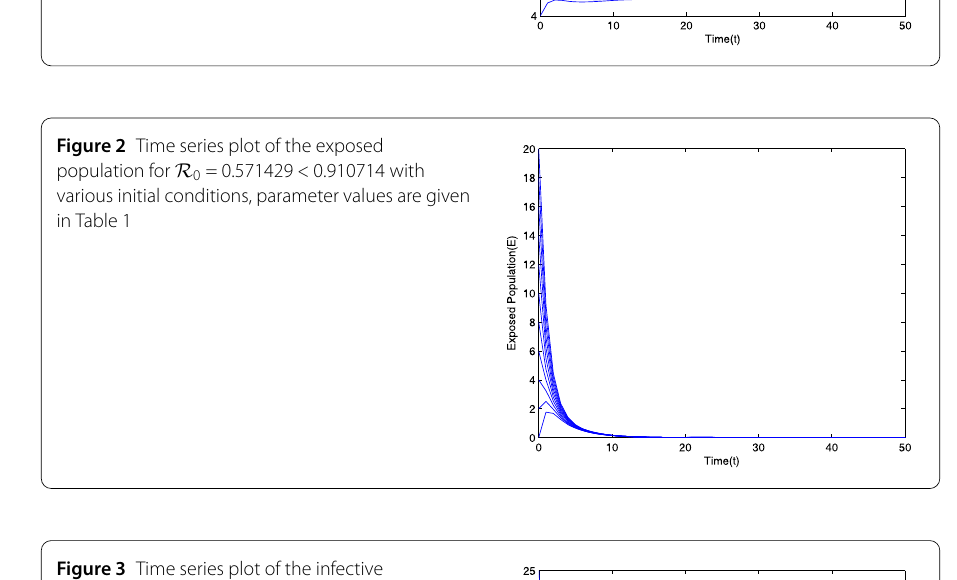
Figure 3 Time series plot of the infective population for R 0 = 0.571429 < 0.910714